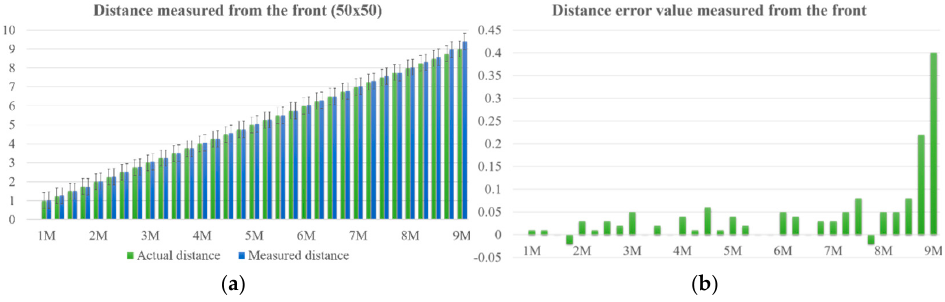
Figure 6. ( a ) Distance measured from the front, ( b ) distance error value measured from the front.